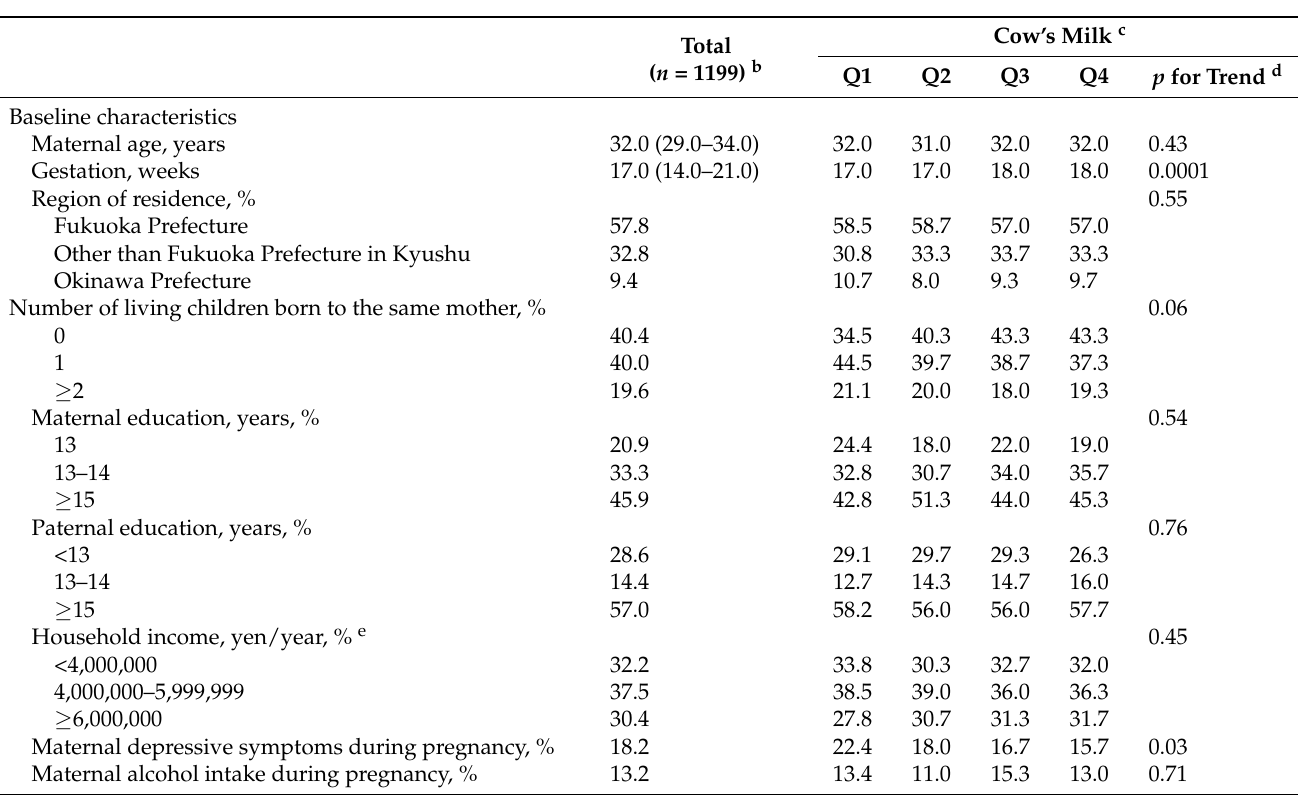
Table 1. Characteristics of 1199 mother–child pairs, according to quartile (Q) of maternal cow’s milk intake during pregnancy a